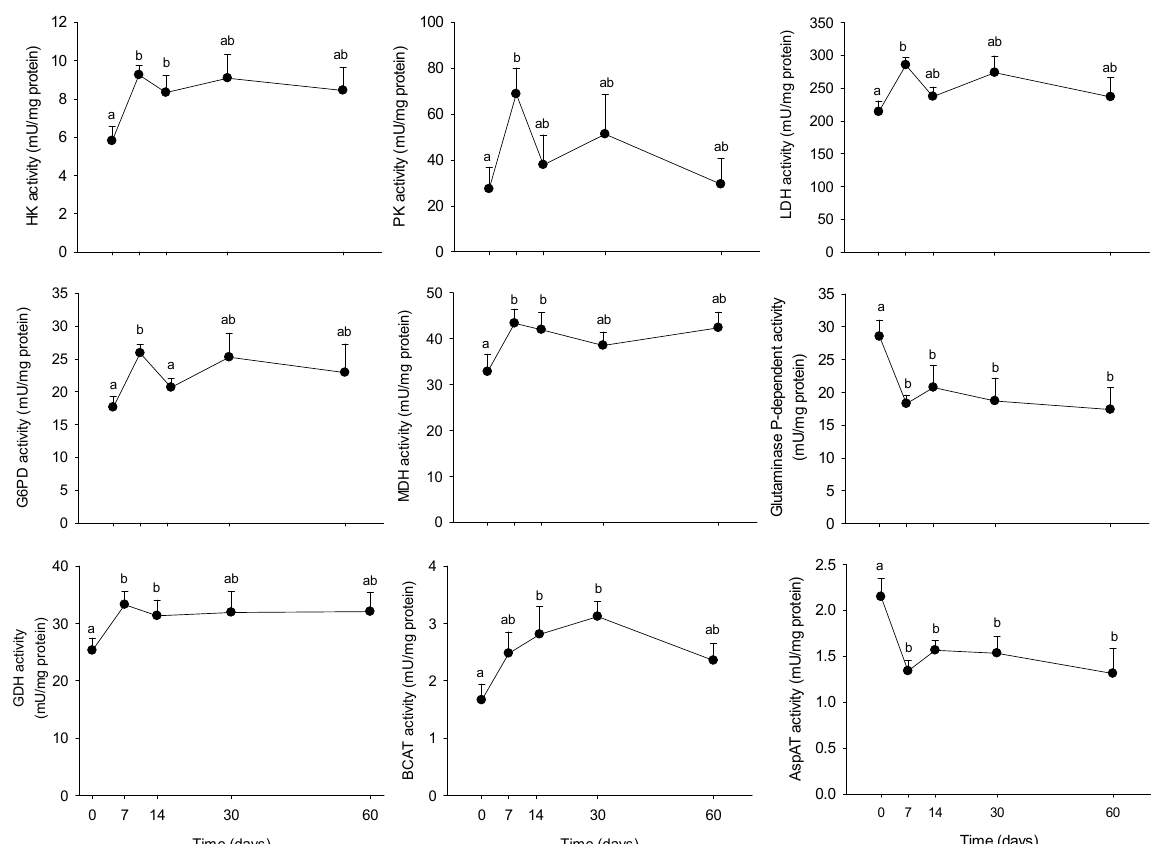
Figure 4. Hexokinase (HK), pyruvate kinase (PK), lactate dehydrogenase (LDH), glucose 6-phosphate dehydrogenase (G6PD), malate dehydrogenase (MDH), branched chain amino-acid transaminase (BCAT), glutaminase P-dependent, aspartate aminotransferase (AspAT), and glutamate dehydrogenase (GDH) alanine transaminase activities in PBMC from Yucatan mini-pigs fed a high fat-high sucrose (HFHS) diet for 2 months. Samples were obtained after an overnight fast period before (0) and 7, 14, 30, and 60 days after HFHS feeding. Enzyme activity units (mU) are defined as nmol of substrate converted to product, per min, at 37 °C and per mg protein. Results are expressed as means + SEM ( n = 5) and were analysed using a one-way ANOVA test followed by post-hoc Holm-Sidak. Different letters indicate significant differences between the sampling points ( p < 0.05).